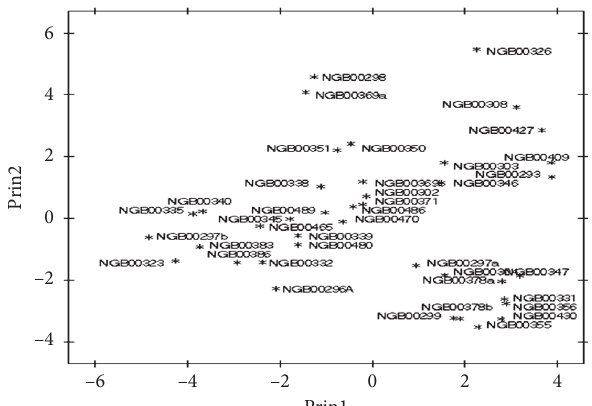
Figure 6: Configuration of the 40 okra genotypes under principal component axes 1 and